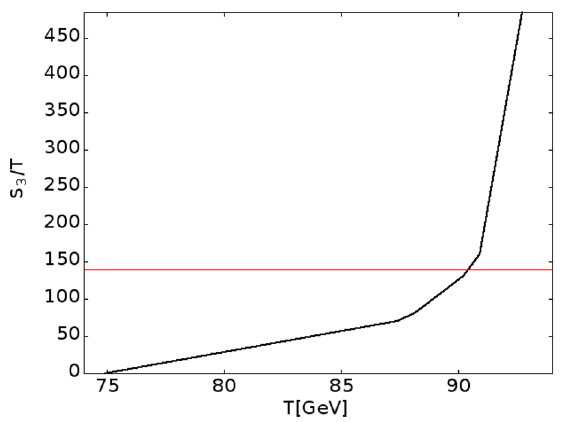
Figure 2. Variation of the parameter S 3 /T as a function of temperature for BP 3. The red horizontal line shows the condition S 3 /T = 140 , where the bubble nucleation occurs.